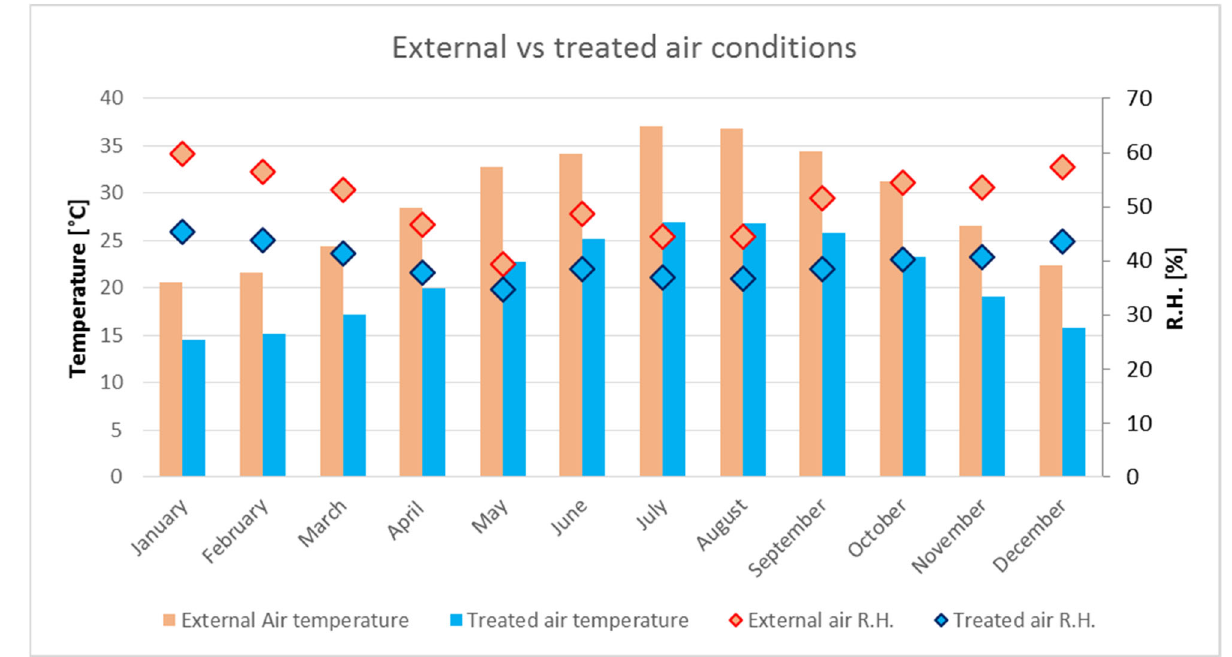
Figure 13. Treated air characteristics in comparison to external air.